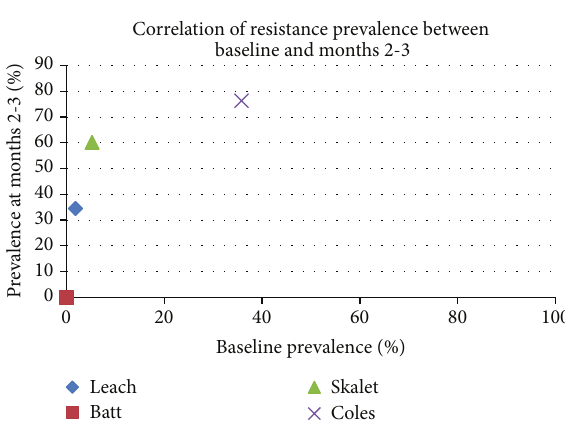
Figure 3: Correlation between prevalence of AZM resistance at baseline and months